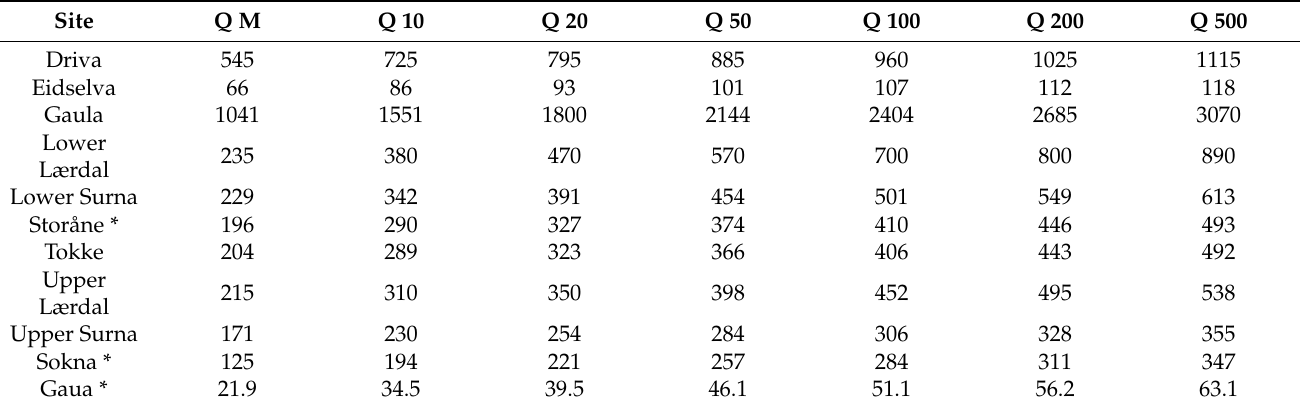
Table 2. Flood scenarios discharges for the sites (in m 3